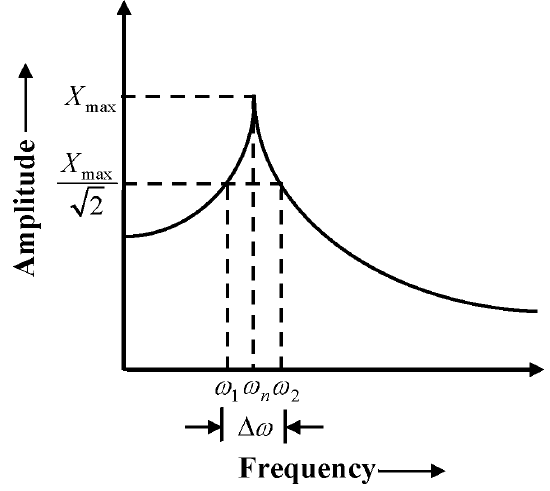
Fig. 3. Half-power bandwidth method for damping